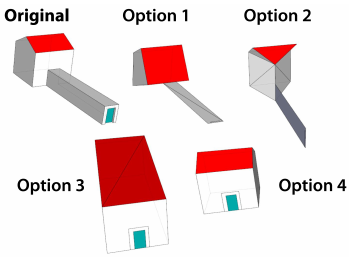
Figure 4. Options for choosing the right projection surface